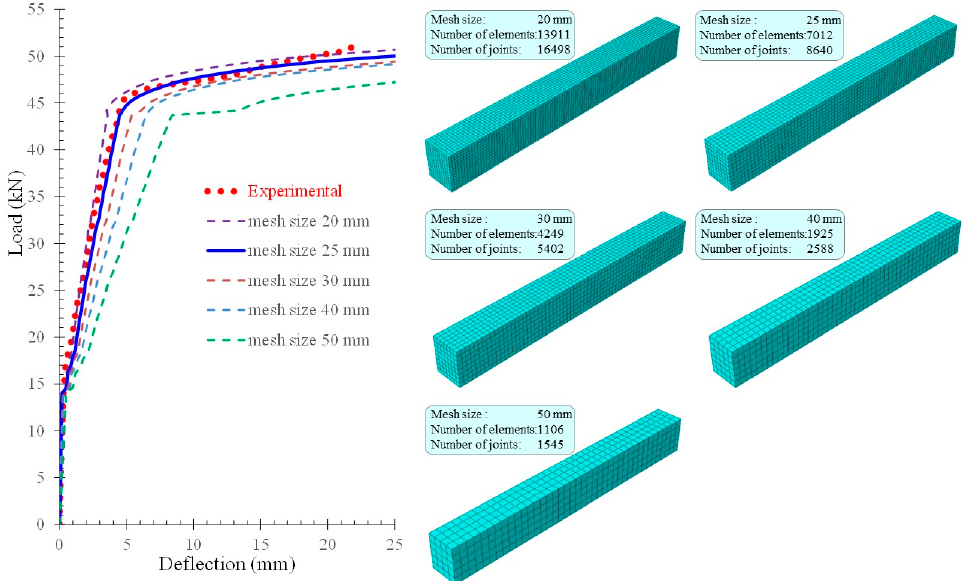
Figure 10. Parametric FEM analysis with different finite element sizes and corresponding mesh size details used for convergence study of the FLM beam.